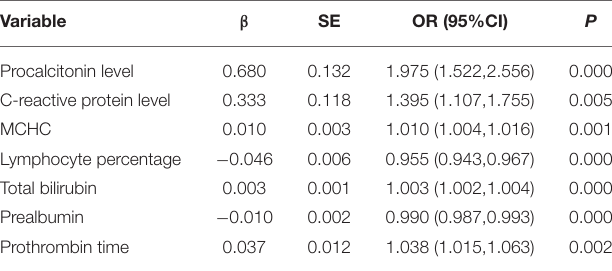
TABLE 3 | Results of multivariate logistic regression